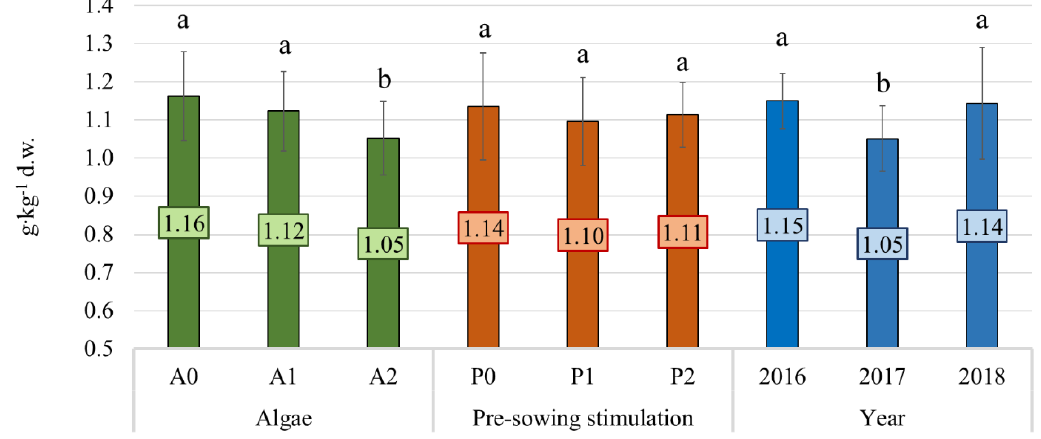
Figure 8. The mean calcium content (g ⋅ kg −1 ) in oat grains in 2016–2018 depending on the experimental factors used. According to Tukey’s HSD test, the means marked with the same letter are not significantly different at α ≤ 0.05.